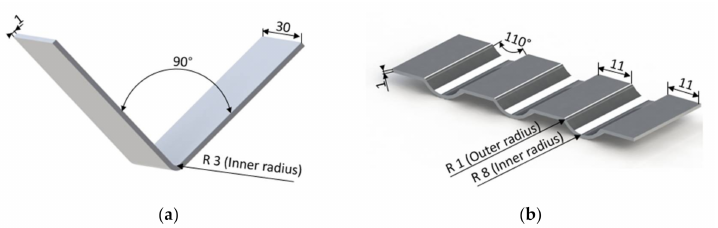
Figure 1. Target geometries with dimensions in mm: ( a ) sheet formed by V-bending; ( b ) sheet formed by groove pressing.